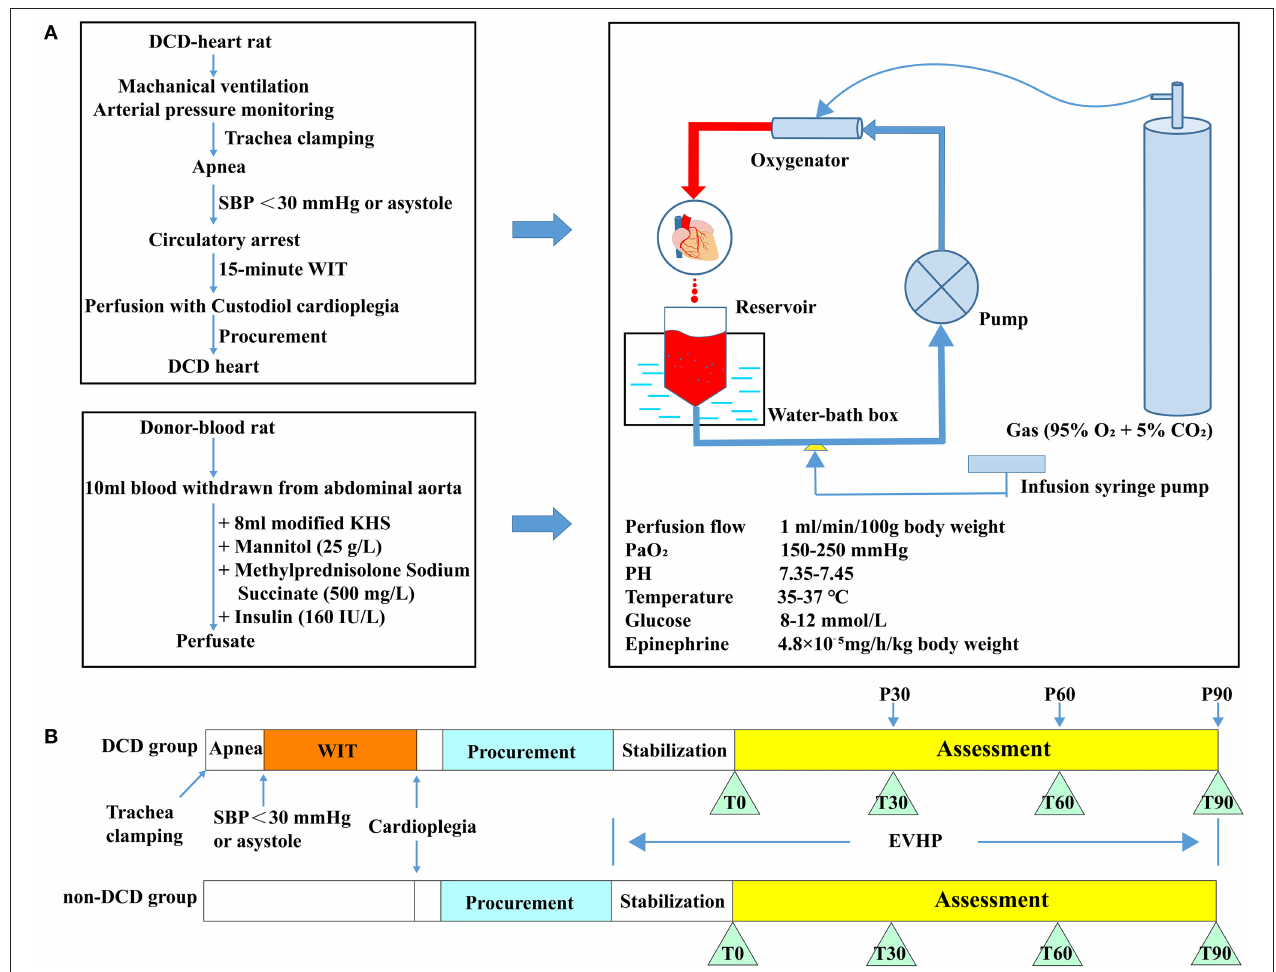
FIGURE 1 | Schematic shows an overview of the protocol of the DCD model combined with normothermic ESHP and experimental design. (A) Protocol of the DCD model combined with normothermic ESHP; (B) Experimental design. DCD, Donation after circulatory death; SBP, Systolic blood pressure; ESHP, Ex situ heart perfusion; WIT, Warm ischemic time; KHS, Krebs-Henseleit solution. Glucose and PH were adjusted according to the result of the blood gas analysis of